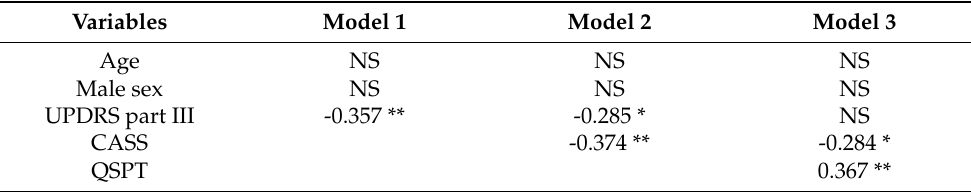
Table 3. Results of multivariate analyses.